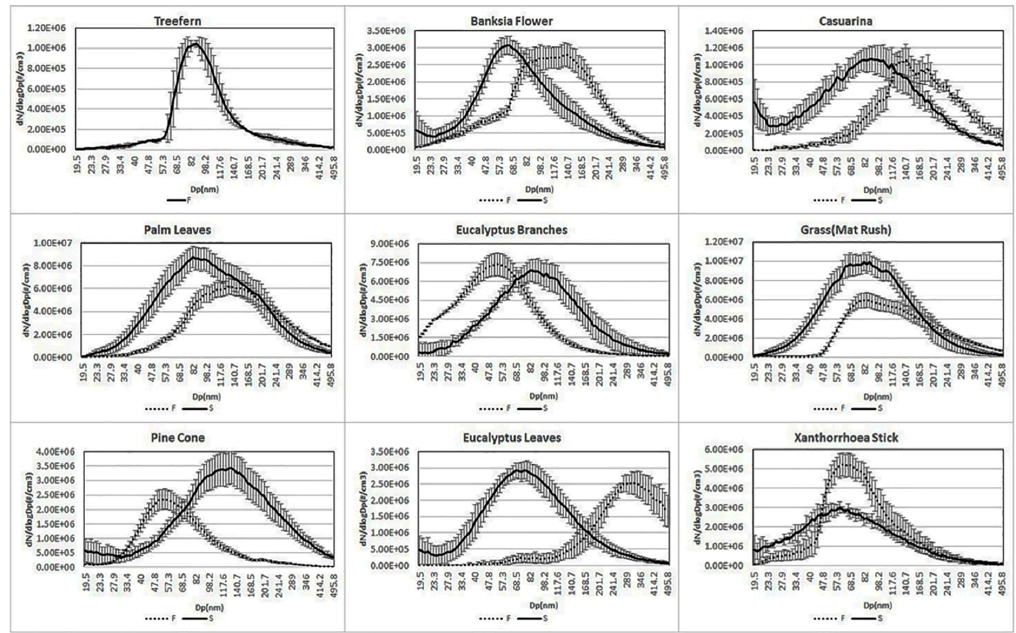
Figure 2. Size distribution of the smoke particles for the flaming (F) and smouldering (S) phases produced by scanning mobility particle sizer (SMPS). Error bars represent standard deviation of at least six replicates.